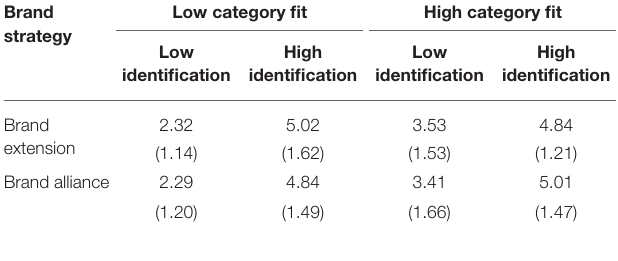
TABLE 3 | Study 1. Mean scores for purchase intention.